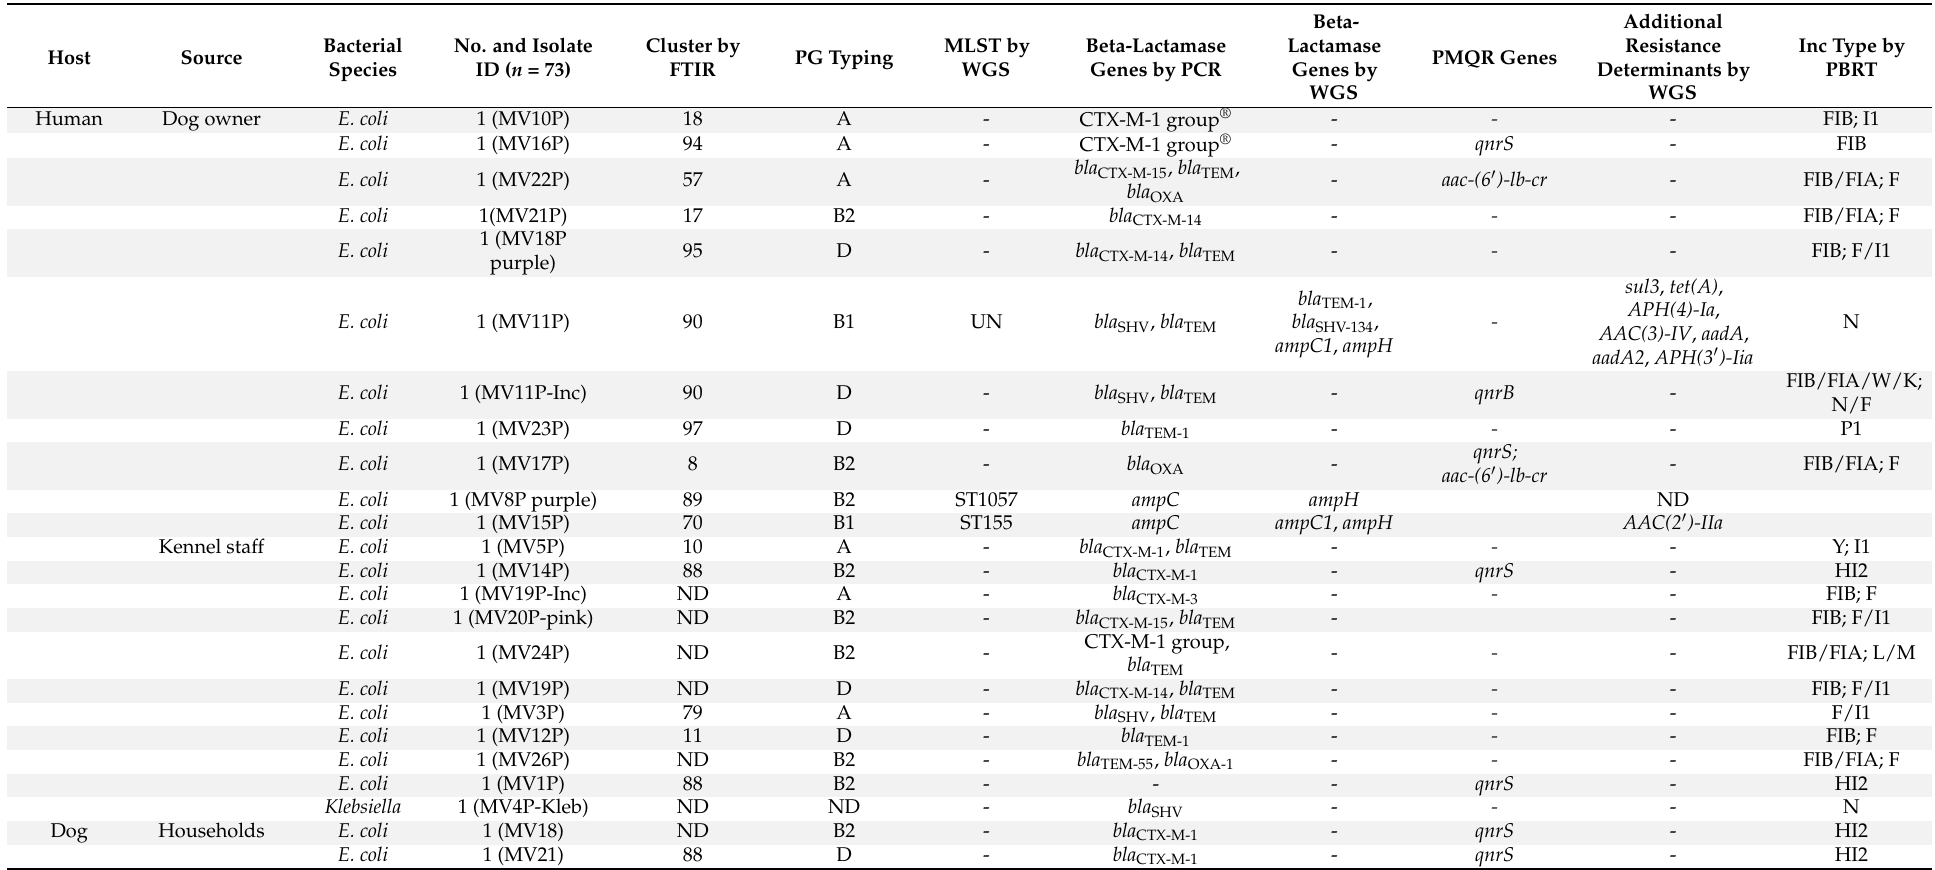
Table 1. Molecular characterisation of extended-spectrum cephalosporin-resistant (ESC-R) Enterobacterales in faecal samples from dogs and humans from households and dog shelters. Only isolates that were identified to carry resistance determinants to ESC or FQs are shown in the table. Abbreviations: FTIR, Fourier transform infrared spectroscopy; PBRT, PCR-based replicon typing; PMQR, plasmid-mediated quinolones resistance genes; ND, not detected; NI = not identified; UN, unknown. ® Represents CTX-M-1 group PCR amplicons not